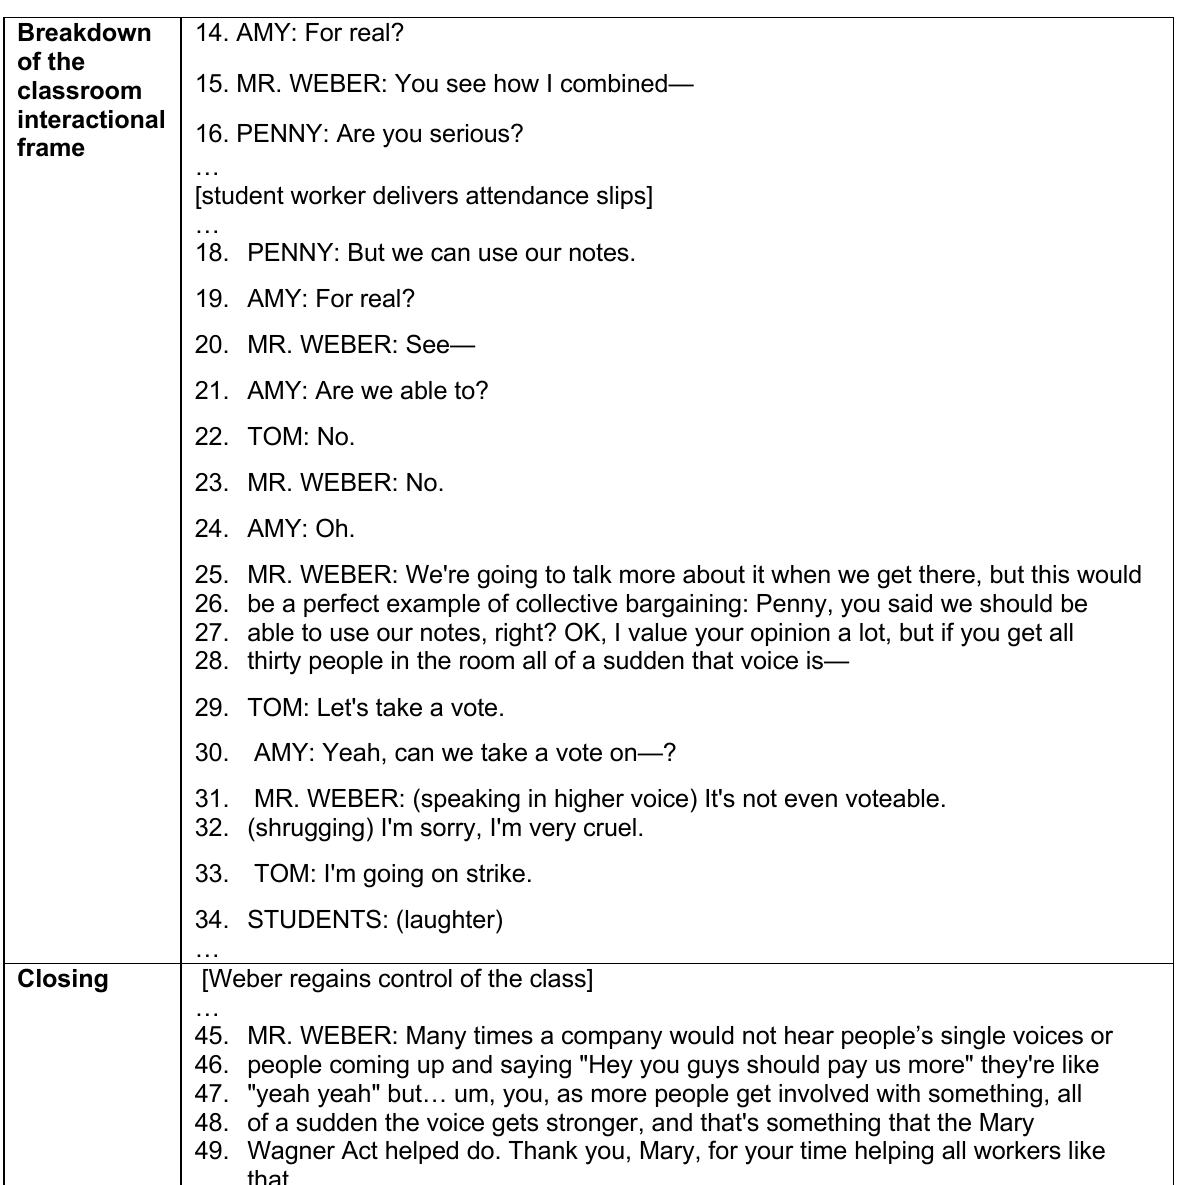
Figure 5. Activity in which a factual conditional narrative (an event that is likely to happen ) resulted in breakdown of the classroom interactional